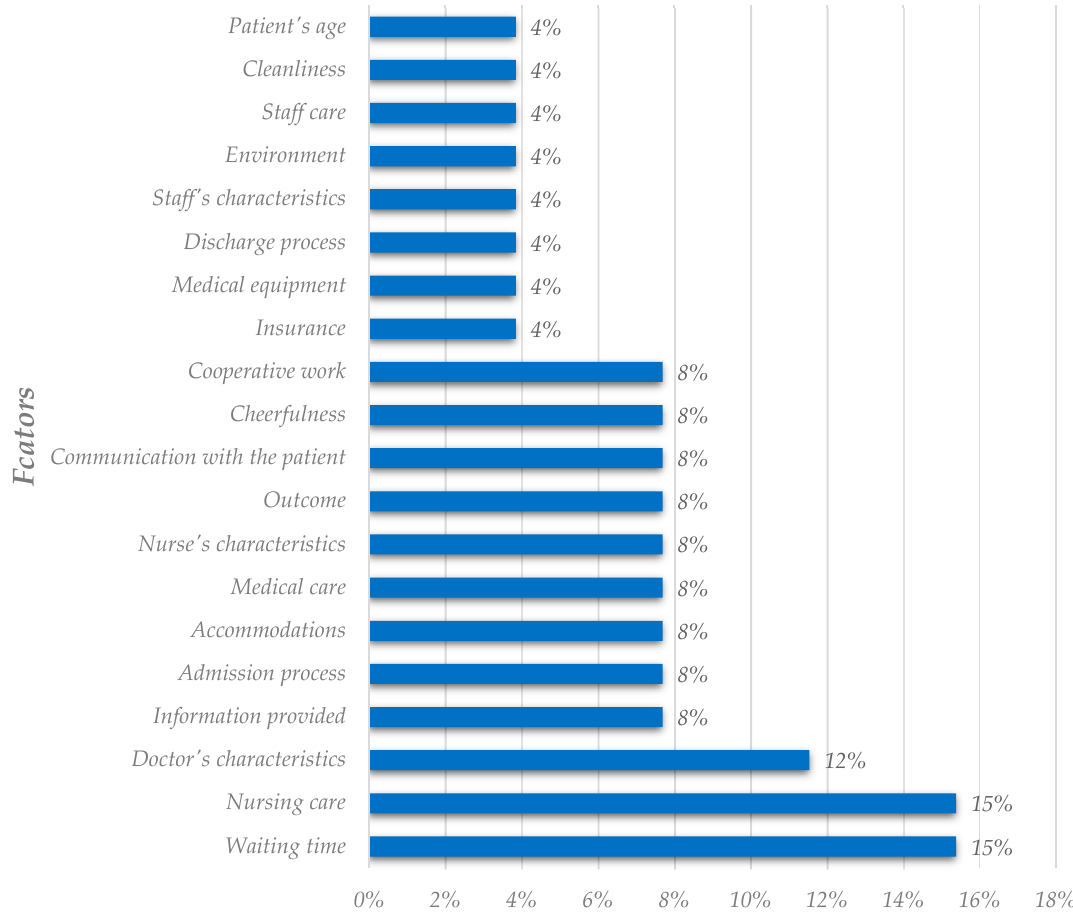
Figure 7. Analysis of factors deemed as the most critical in the literature (willingness to recom- mend